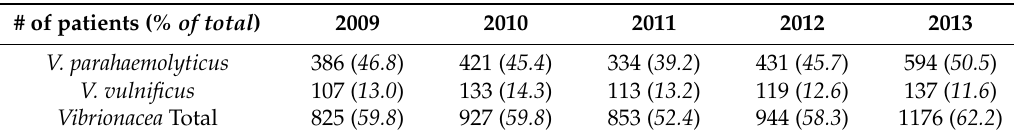
Table 2. Number of vibriosis patients who reported eating seafood, consumed raw oysters, or raw clams in the United States (2009–2013) [28–32]. Table 2. Number of vibriosis patients with V. parahaemolyticus and V. vulnificus in the United States